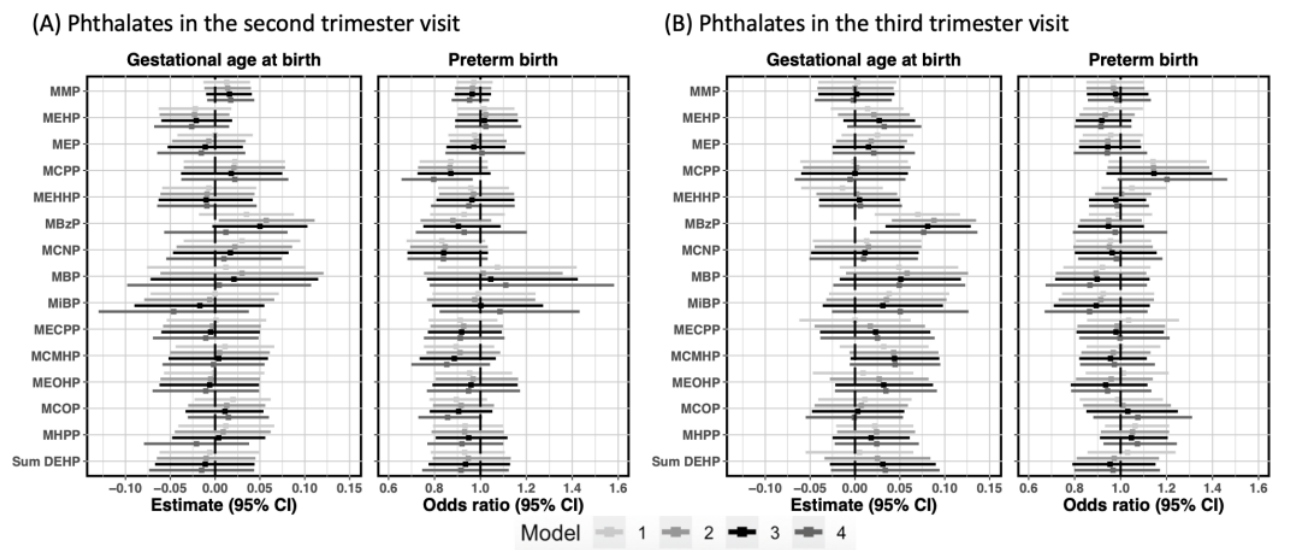
Figure A2. Estimated associations between prenatal phthalates in each visit and birth outcomes in CANDLE participants with complete data of phthalate measurements in either visit and birth outcome.